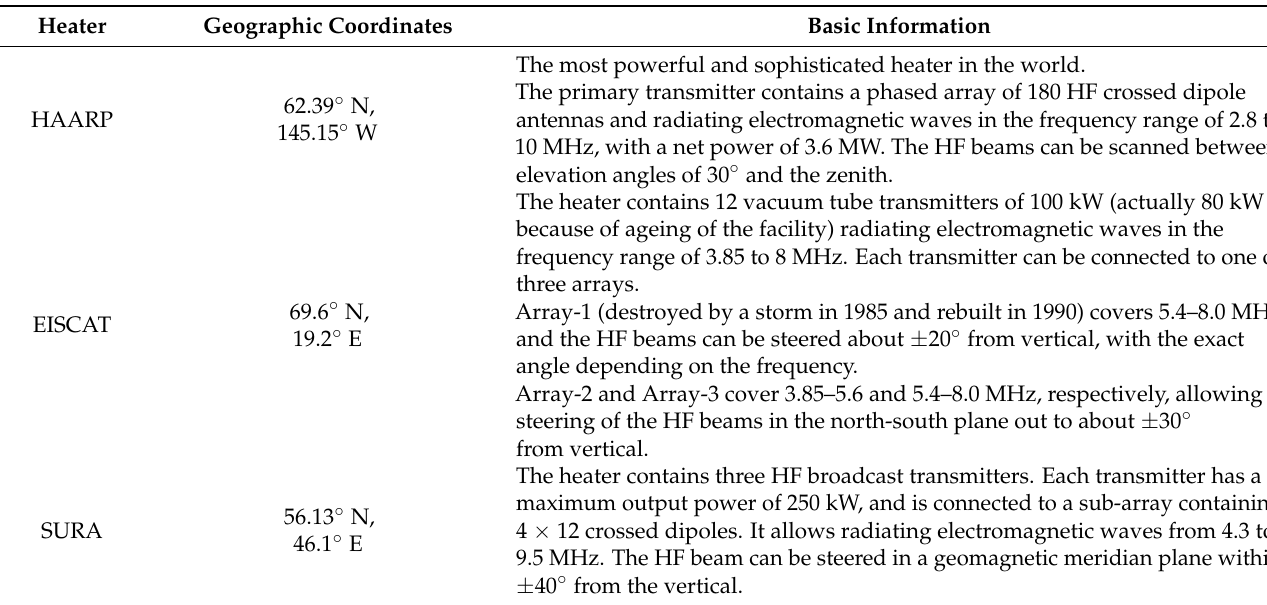
Table 1. Information on three heaters (HAARP (High-frequency Active Auroral Research Program, US facility), EISCAT (European Incoherent SCATter Scientific Association, European facility), and SURA (Russian facility)) [11,15,16]. Heater Geographic